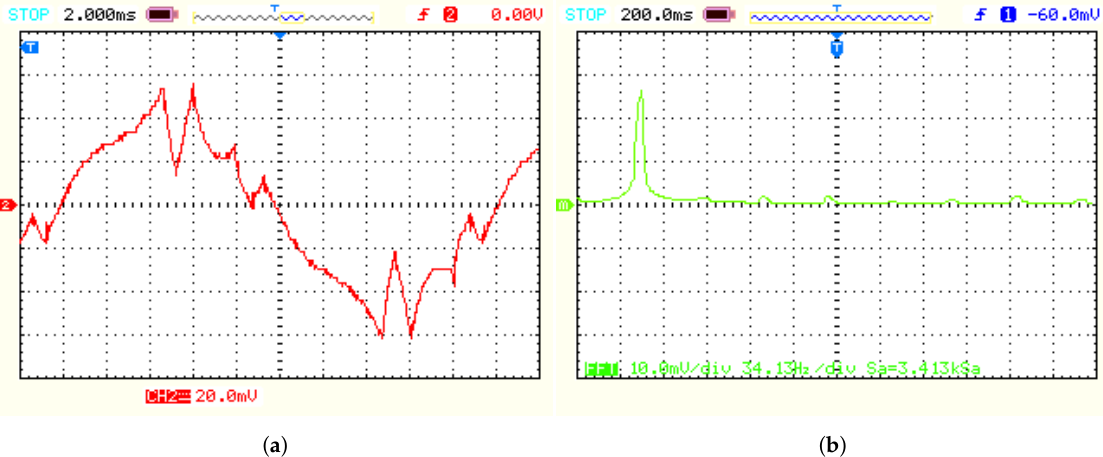
Figure 14. ( a ) Motor current in steady state; ( b ) THD of the motor